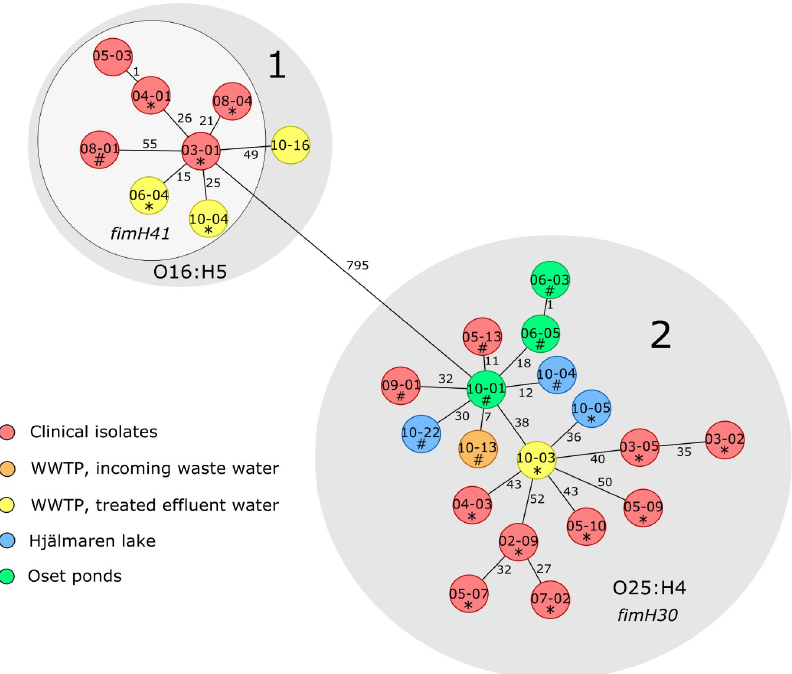
Fig 3. Minimum spanning tree (MST) of the ST131 isolates. The MST shows all ST131 isolates found in patients and the environment (n = 26) and is based on allele differences in 2682 core genes. Each circle represents one isolate. Isolates marked with � carried bla CTX–M–15 and isolates marked with # carried bla CTX–M–27. The different colors show the sampling locations and the numbers next to the lines connecting the circles show the number of allele differences between the